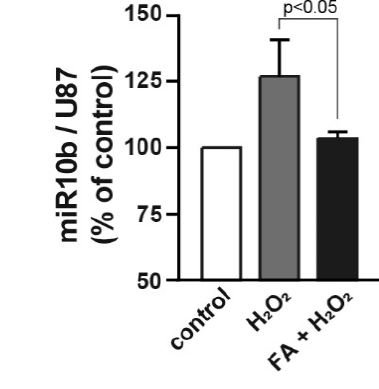
Figure 3. FA inhibits H 2 O 2 -induced phosphokinases in PC12 cells. ( a ) PC12 cells were pretreated with FA (40 µM) overnight and subsequently cultured cells in the absence or presence of H 2 O 2 (0.5 mM) for another 30 min. Cell lysates were evaluated by phosphoprotein kinase antibody array according to the manufacturer’s instructions. The intensity of each dot/phospho- protein was measured using Image J software. ( b ) Results of the array were validated by Western blot analysis.